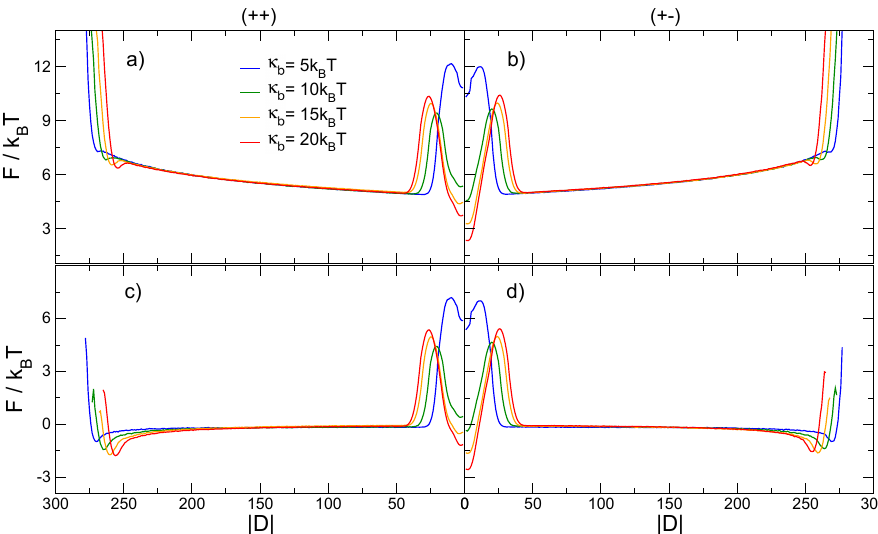
Figure 4. Free energy F as a function of the collective order parameter | D | , i.e., the absolute linear distance between the centers of the two knots. F ( | D | ) for different values of the chain bending rigidity κ b is reported for ( a ) two trefoil knots with the same relative chirality and ( b ) two trefoil knots with opposite relative chiralities. In ( c , d ) we show the same free energies, but with subtracted entropic contribution − TS ( | D | ) , as defined in Equation